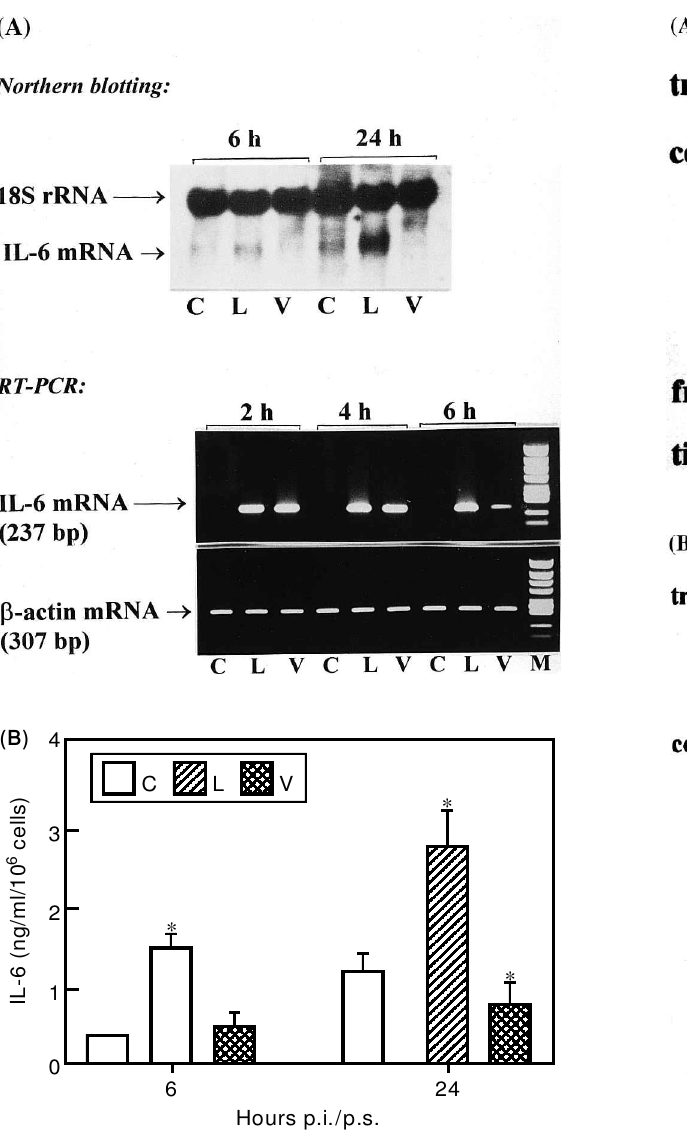
FIG. 4. Effect of vaccinia virus infection on IL-6 expression in human endothelial cells. IL-6 mRNA was measured for 6 and 24h samples by hybridization with human cDNA probe giving also unspecific signal with 18S rRNA. Additionally, 2, 4 and 6h RNA samples were analysed by RT-PCR (A). The cytokine protein was determined by ELISA in the culture media from three separate experiments and expressed in ng/ ml of medium and 10 6 cells. Vaccinia virus infection was at MOI 2:1. LPS-stimulated cultures were used as the positive control. p.i.–post infection; p.s.–post stimulation. Results are expressed as the mean ± standard deviation. Statistically significant results and P values < 0.01 are marked by*.